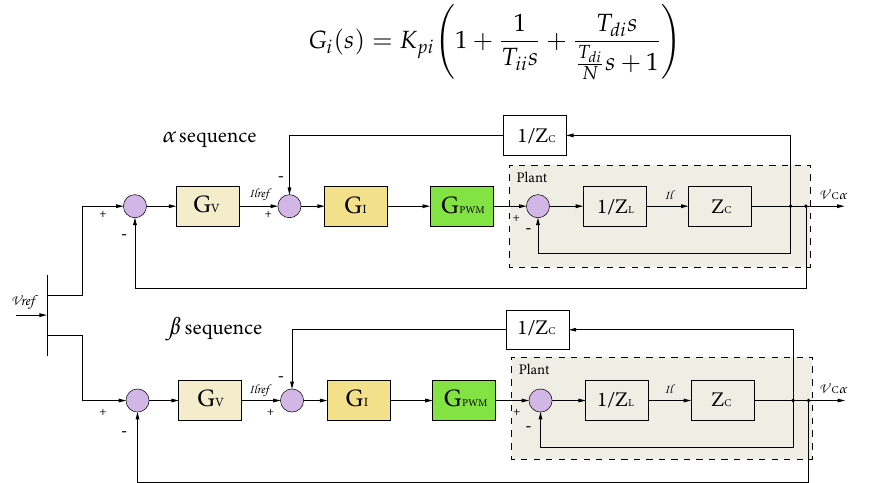
Figure 3. Primary control block diagram, including voltage and current